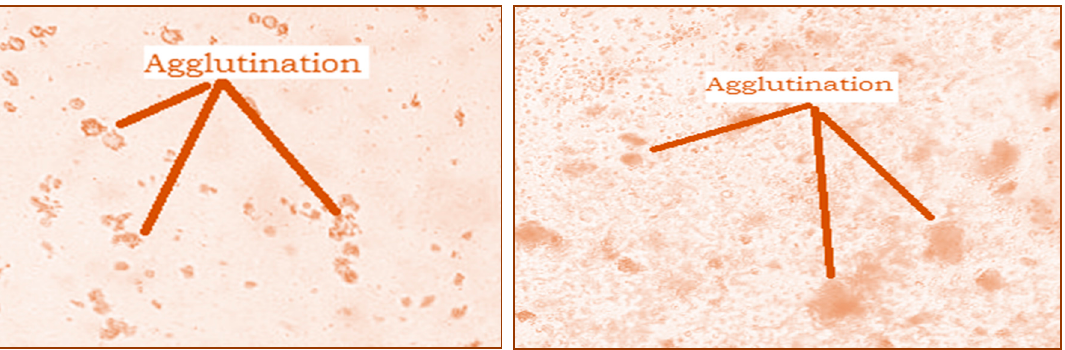
Figure 5. Microscopic observation (G × 40) of agglutination of rat red blood cells by Nigella sativa and Lepidium sativum extracts.